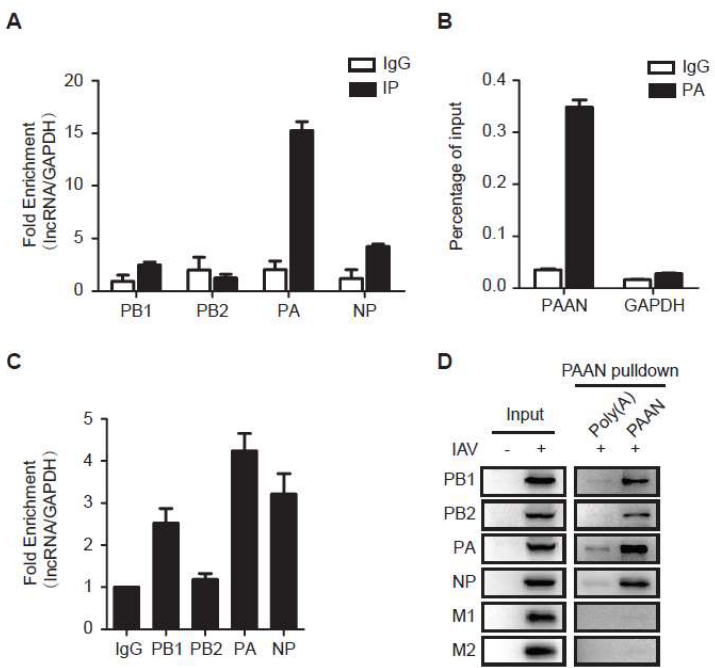
Figure 6. LncRNA-PAAN is associated with IAV PA protein. ( A , C ) RIP experiment was performed to detect the association of lncRNA-PAAN RNA with the viral proteins. HEK293T cells were transfected with plasmid DNA expressing PB1, PB2, PA or NP ( A ) and infected with IAV (MOI = 0.5) for 36 h ( C ). Cell lysates were immunoprecipitated with the indicated antibodies, and levels of lncRNA-PAAN and GAPDH were determined by qRT-PCR. IgG was used in immunoprecipitation; the results serve as the control; ( B ) Cross-linked RIP experiment was performed to detect the association of lncRNA-PAAN with viral PA protein. HEK293T cells were transfected with plasmid DNA expressing lncRNA-PAAN and PA. Cells was crosslinked, and lysates were immunoprecipitated with the anti-PA antibody. Levels of lncRNA-PAAN and GAPDH were determined by qRT-PCR. IgG was used in immunoprecipitation; the results serve as the control; ( D ) RNA pulldown assay was performed to detect the association of lncRNA-PAAN RNA with the viral proteins. HEK293T cells were infected with IAV (MOI = 0.5) for 36 h. Cell lysates were incubated with biotinylated RNA probes of PAAN. The pull-down products were examined by western blotting with the indicated antibodies. IAV means the WSN strain unless otherwise specified.